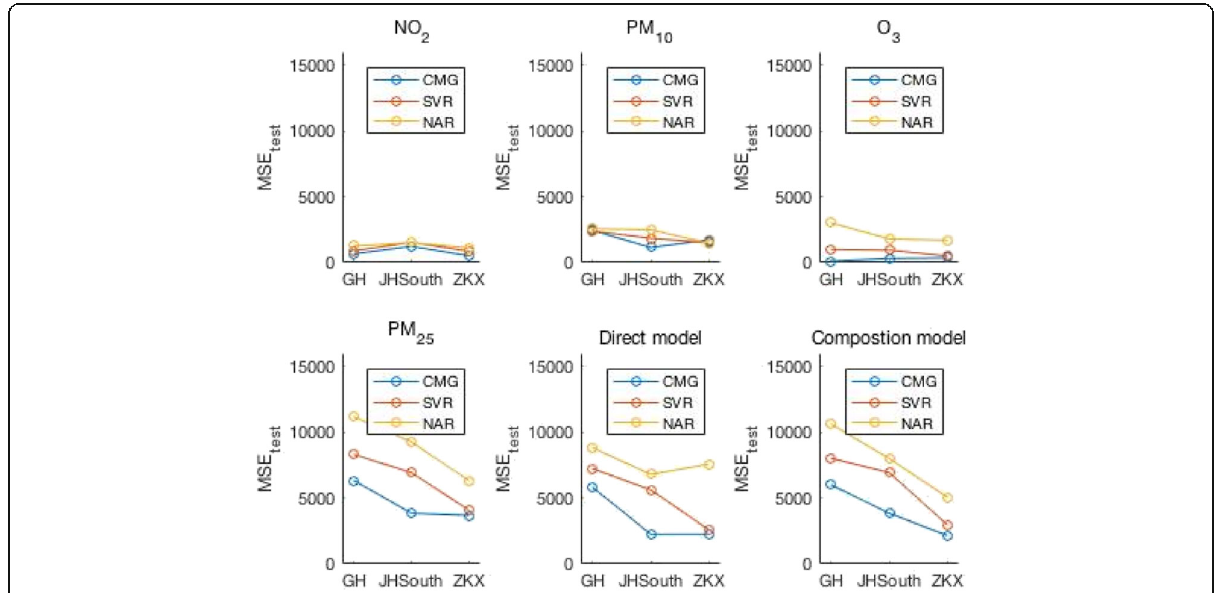
Fig. 4 MSE test for AQI prediction. The first subgraph shows the MSE test of three algorithms (CMG, SVR, NAR) for NO 2 prediction. The second subgraph shows the MSE test of three algorithms (CMG, SVR, NAR) for PM 10 prediction. The third subgraph shows the MSE test of three algorithms (CMG, SVR, NAR) for O3 prediction. The fourth subgraph shows the MSE test of three algorithms (CMG, SVR, NAR) for PM 25 prediction. The fifth subgraph shows the MSE test of three algorithms (CMG, SVR, NAR) for AQI prediction on direct model. The sixth subgraph shows the MSE test of three algorithms (CMG, SVR, NAR) for AQI prediction on composition